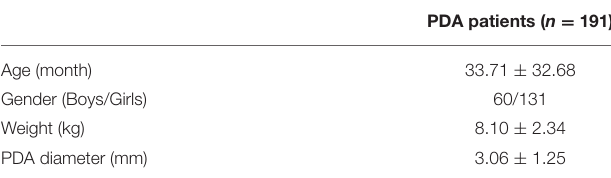
FIGURE 1 | Receiver operating characteristic curve of pre-closure LVEF, PDAd/AOd, and LAd/AOd echocardiography parameters for predicting LV systolic dysfunction. TABLE 1 | Clinical data of 191 children undergoing PDA occlusion.